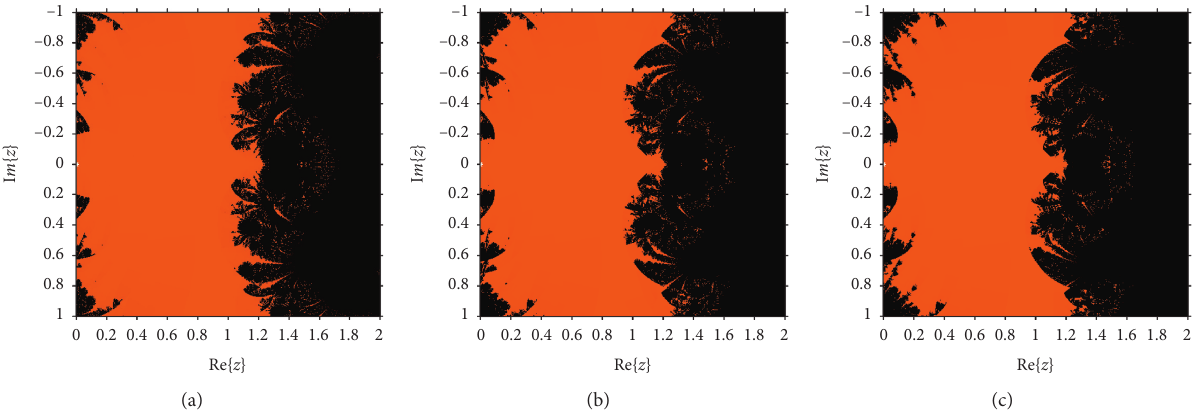
Figure 7: Basins of attraction of (a) BM1, (b) AM2, and (c) ZM3 for g